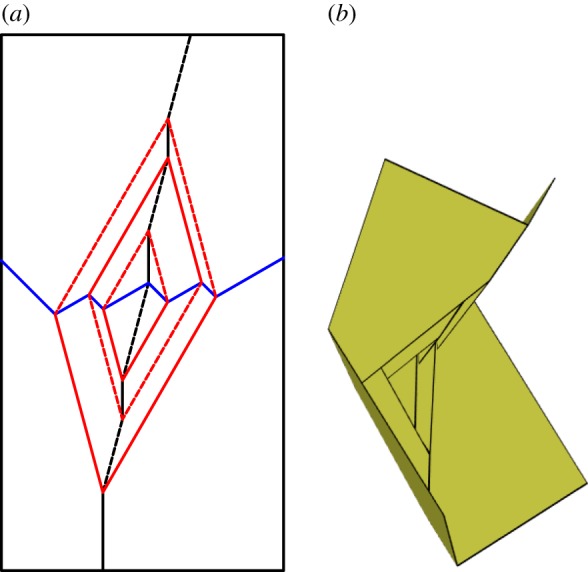
Recursive corner gadget. Note that each successive interior vertex is a rotation of the previous interior vertex by 180°. Mountain folds are indicated by solid lines and valley folds by dashed lines. Fold lines of the same colour have the same fold angle. (a) Fold pattern and (b) partially-folded state.